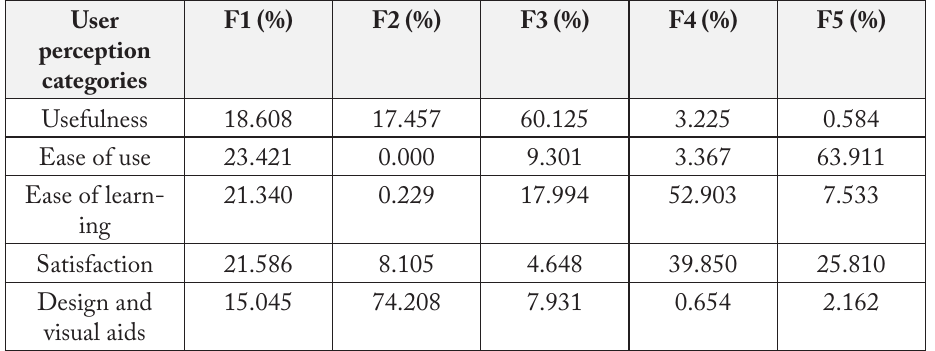
Table 6: Percentage contributions of five factors to user perception categories User